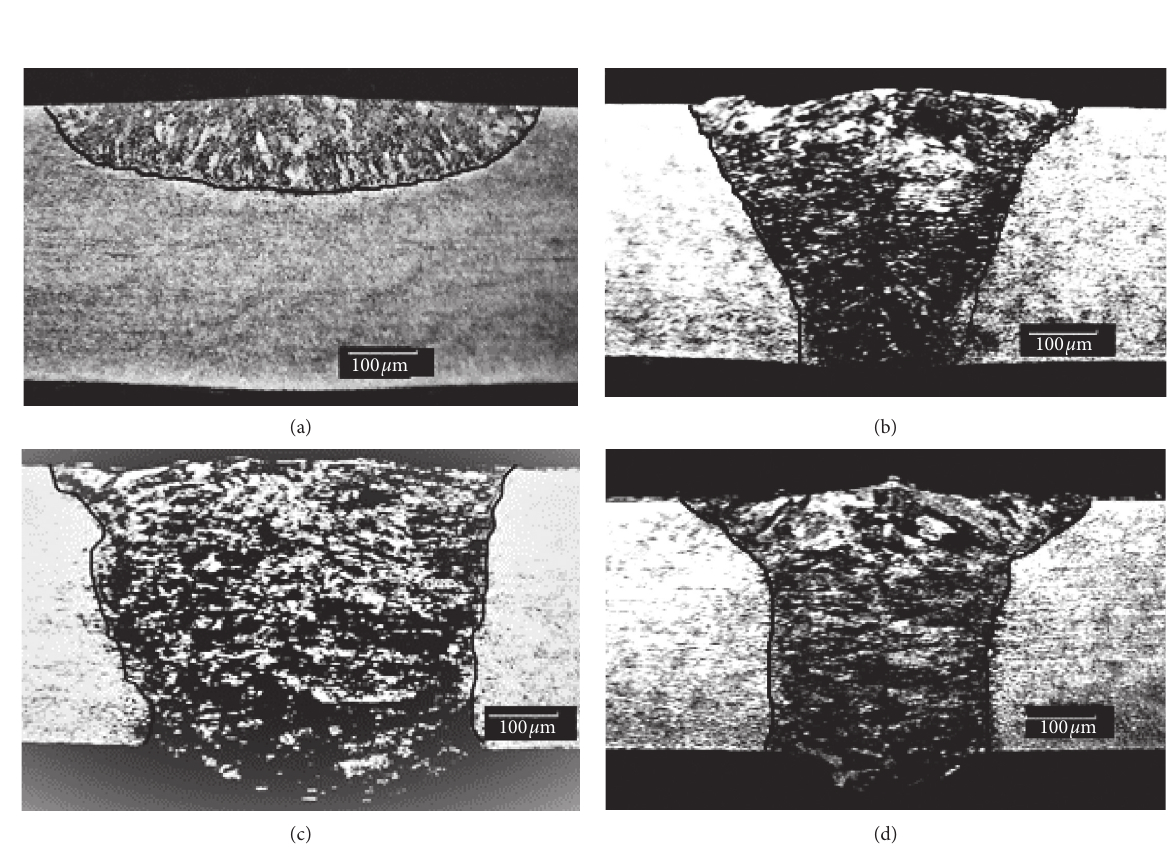
Figure 5: Morphology of TIG and ATIG welds: (a) TIG, (b) ATIG 1, (c) ATIG 2, and (d) ATIG 3. (a) TIG weld bead. (b) ATIG 1 weld bead. (c) ATIG 2 weld bead. (d) ATIG 3 weld bead.